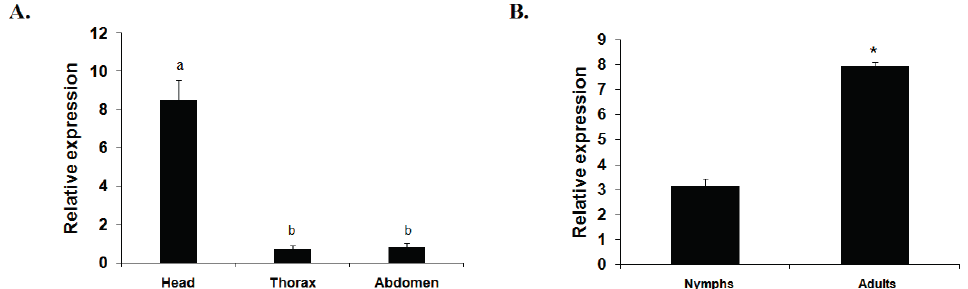
Figure 4. The relative mRNA expression profiles of TciRyR . ( A ) Expression profiles in different adult body parts including the head, thorax, and abdomen; ( B ) Expression profiles during different developmental stage including nymph and adult. Different letters above each bar indicate statistical difference by ANOVA ( * p <0.05).